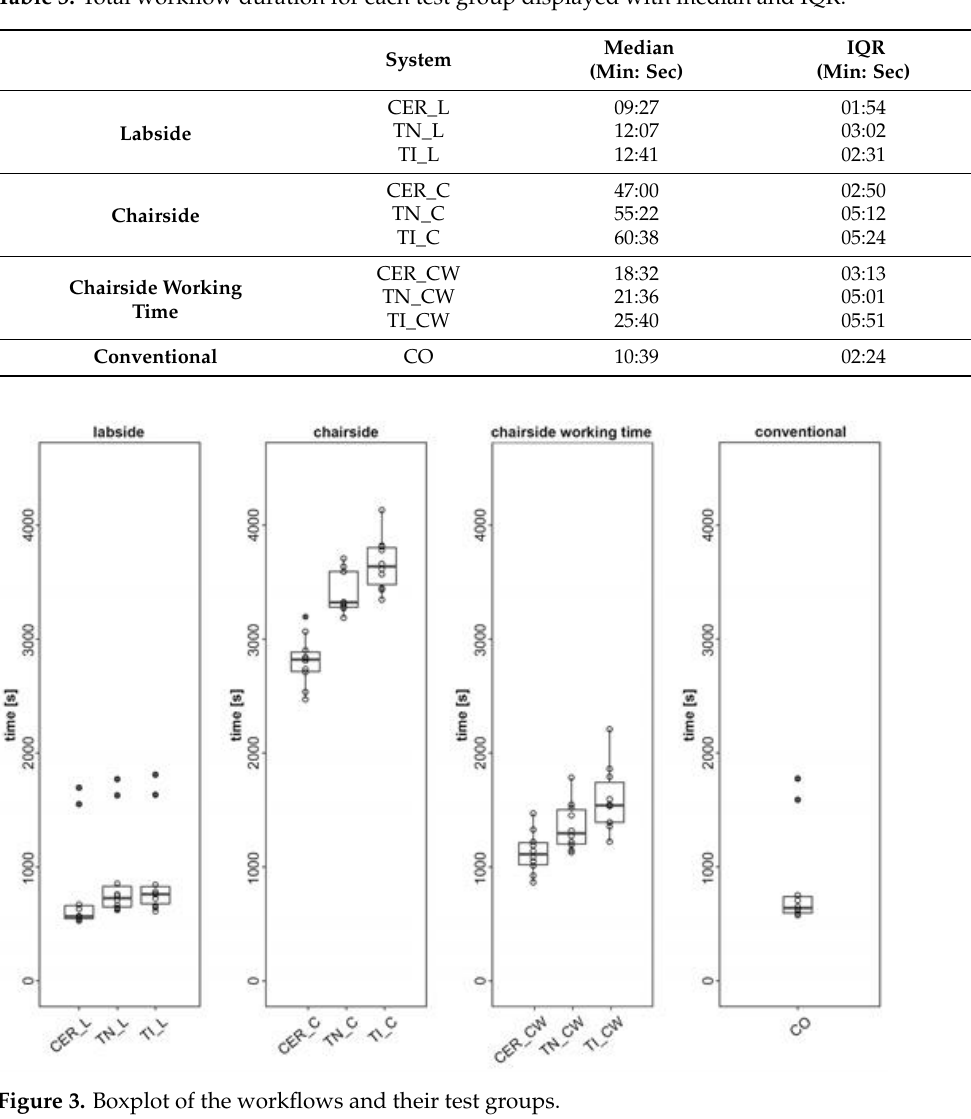
Figure 3. Boxplot of the workflows and their test groups.